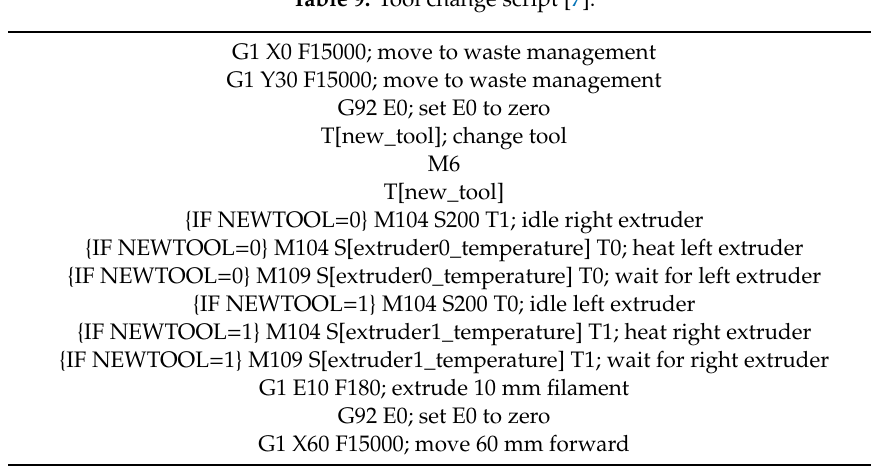
Table 9. Tool change script